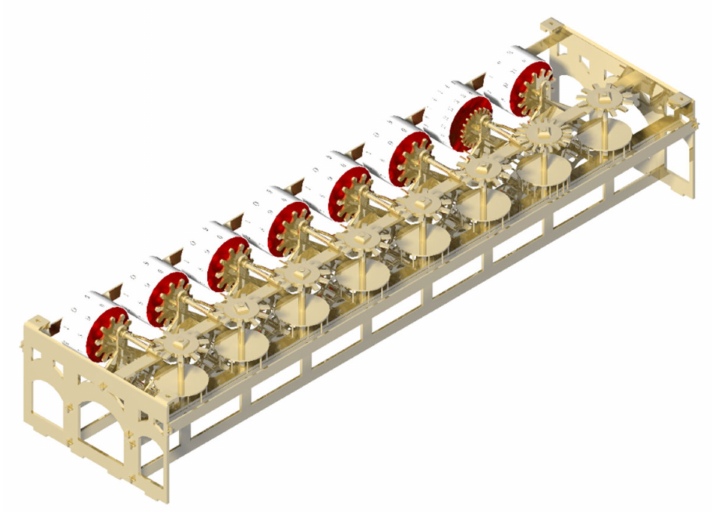
Figure 23. Complete mechanism assembled in the structure.